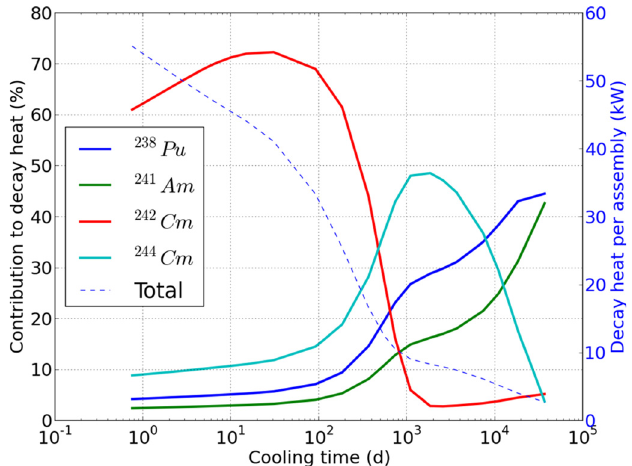
Fig. 2. Cooling time for various limiting values depending on the fraction of 241 Am in the americium isotopic vector. A minimal cooling time of 5 years was